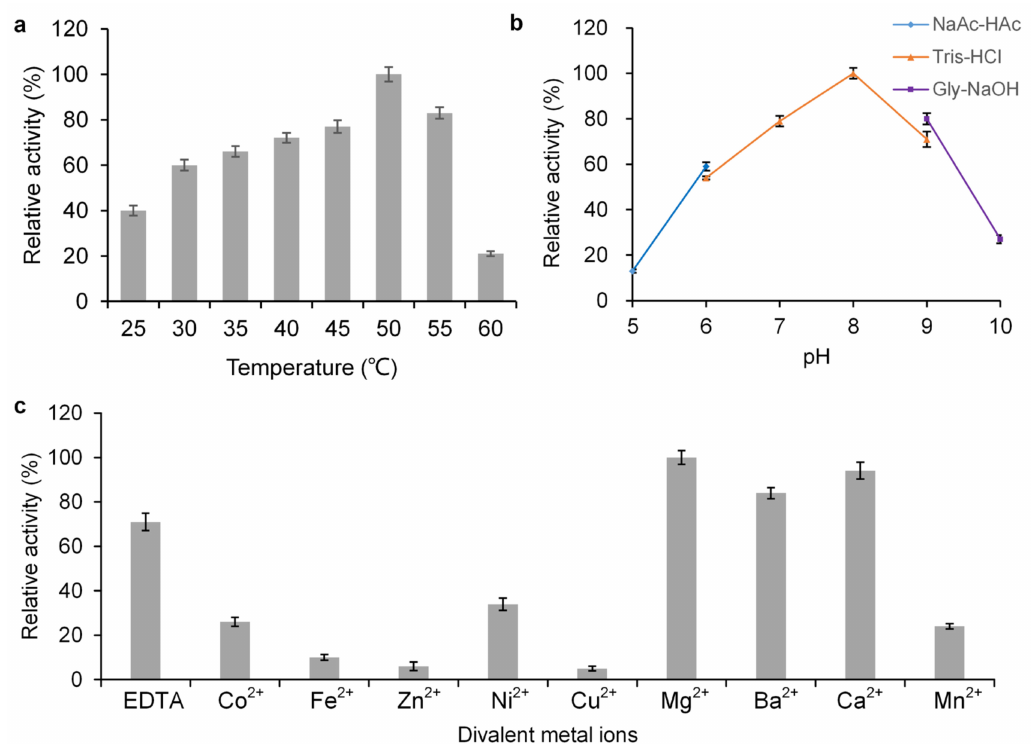
Figure 2. E ff ects of reaction pH, temperature, and metal ions on the activity of GT-SM. ( a ) Relative activity of GT-SM at various temperatures (25 ◦ C–60 ◦ C). ( b ) Relative activity of GT-SM at di ff erent pH conditions (pH 5.0–10.0). ( c ) Relative activity of GT-SM in various metal ions.